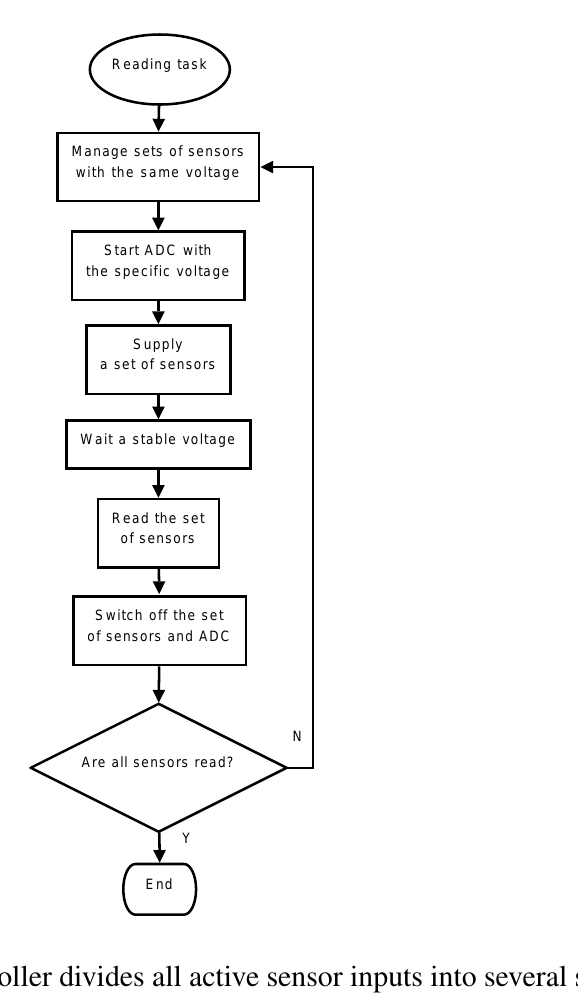
Figure 9. Flowchart showing the periodic task of reading several sensor with different power